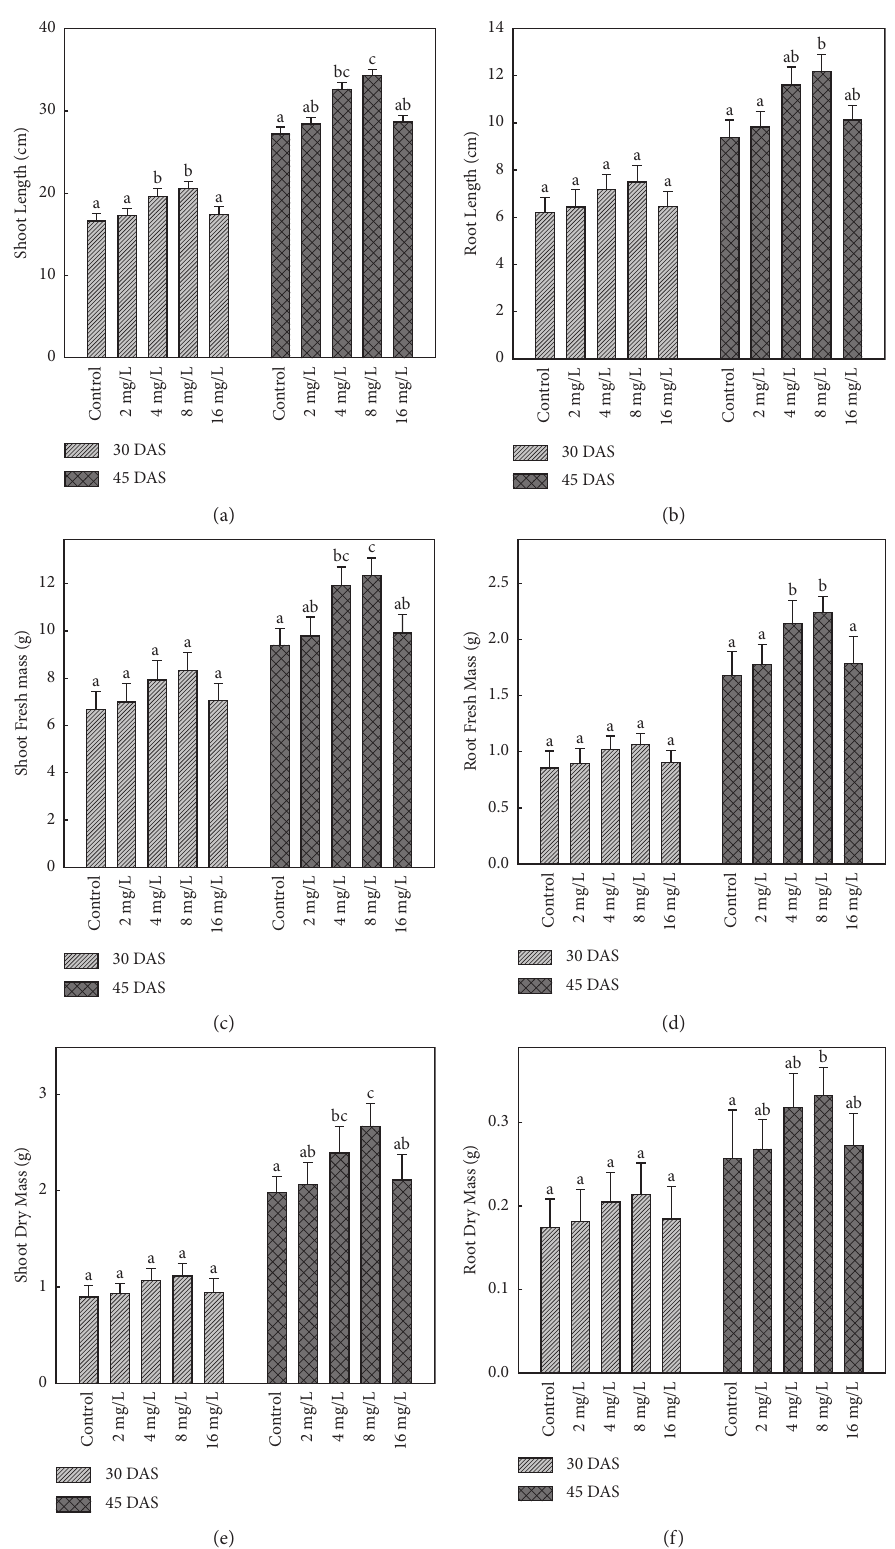
Figure 1: Effect of nanoparticles (NPs) on the length of shoot (a), root length (b), fresh mass of shoot (c), root (d), dry mass of shoot (e), and root (f) of mustard at 30 and 45 DAS. All the data are the mean of five replicates ( n � 5), and vertical bars shows standard errors ( ± SE). (Different alphabet represents the significant difference ( p < 0 . 05) of treatments compared to the control